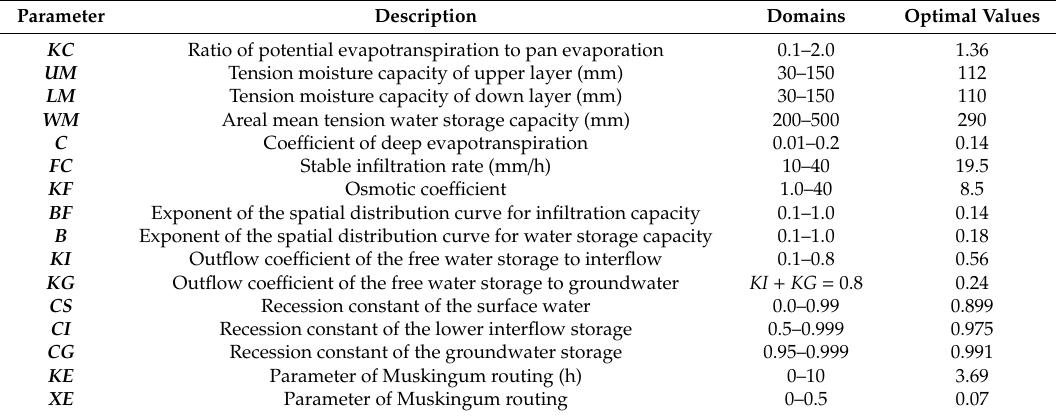
Table A2. Parameters of the proposed model along with their descriptions and ranges for Xiuwu Basin.